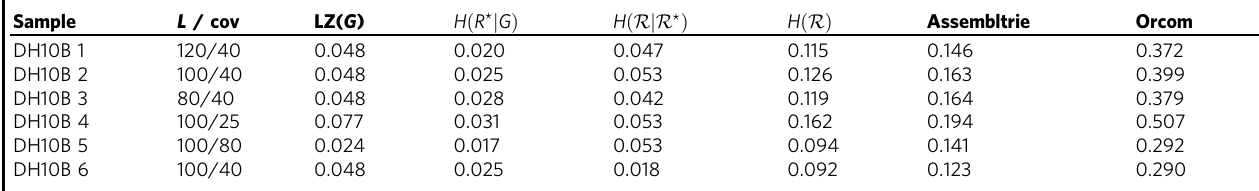
Table 5 Assembltrie ’ s compression performance is comparable to our entropy approximation for E. coli read collection